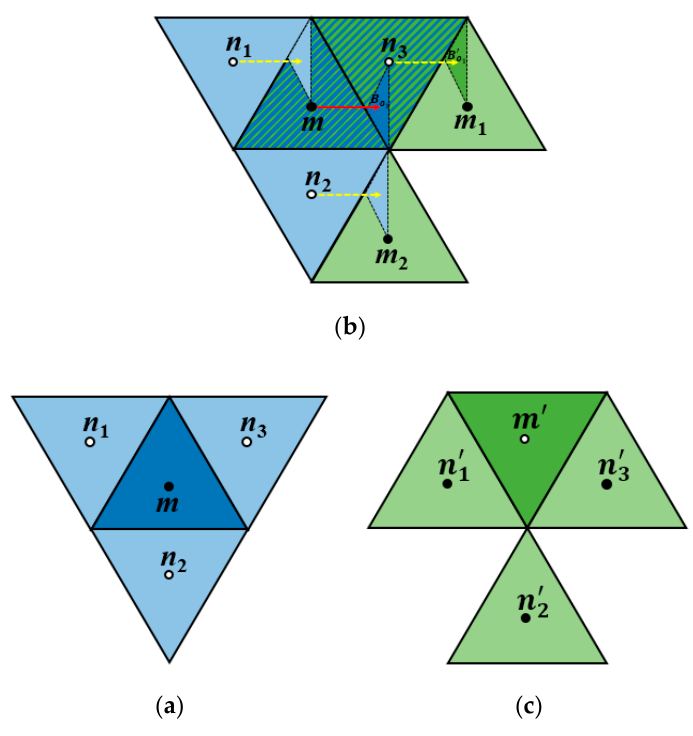
Figure 10. ( a ) An even pixel and its neighbors, the three odd pixels, before translation. ( b ) A translation by a vector that belongs to the semi-bijective region 𝐵 (cid:3042) 𝑚 (cid:4593) , 𝑛 (cid:2869)(cid:4593) ,𝑛 (cid:2870)(cid:4593) , and 𝑛 (cid:2871)(cid:4593) are the images of 𝑚, 𝑛 (cid:2869) , 𝑛 (cid:2870) , and 𝑛 (cid:2871) respectively. The pixels 𝑚 (cid:4593) and 𝑛 (cid:2870)(cid:4593) are not